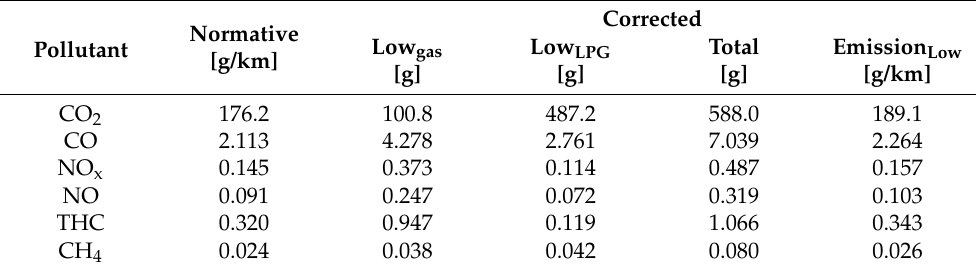
Table A3. Comparison of exhaust emissions calculated by the normative and corrected method for the Low phase of the WLTC cycle—measurement No. 3.